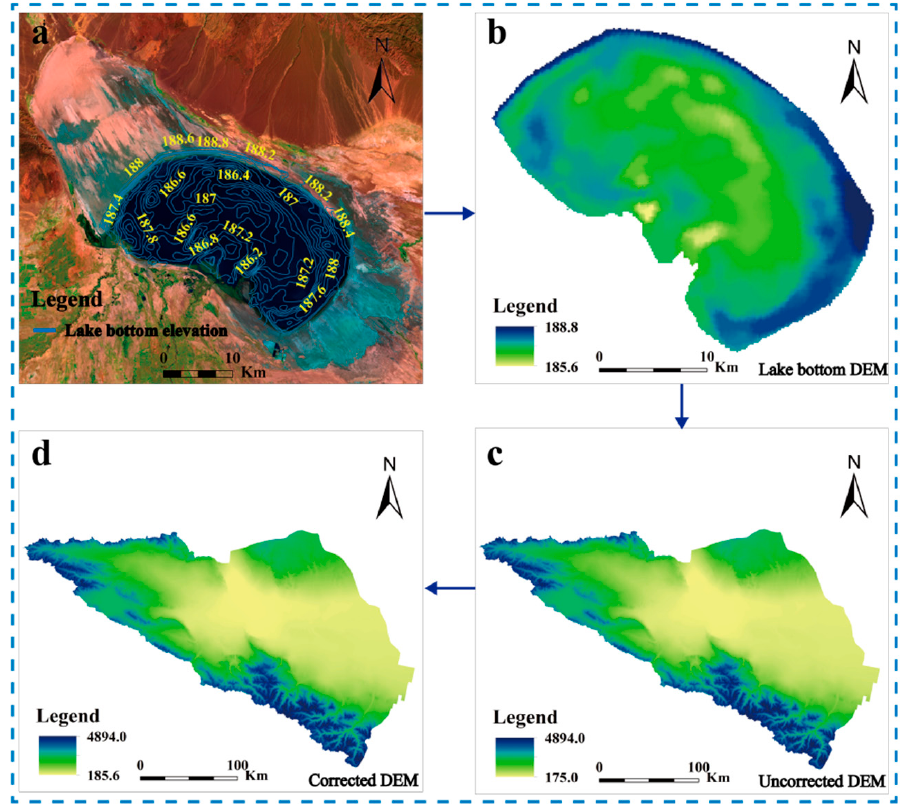
Figure 7. Topography of the bottom of Ebinur Lake. ( a ): Vectorization of lake bottom elevation; ( b ): Generate lake bottom DEM; ( c ): Original DEM of Ebinur Lake Basin; ( d ): DEM of Ebinur Lake basin after lake bottom topography correction.